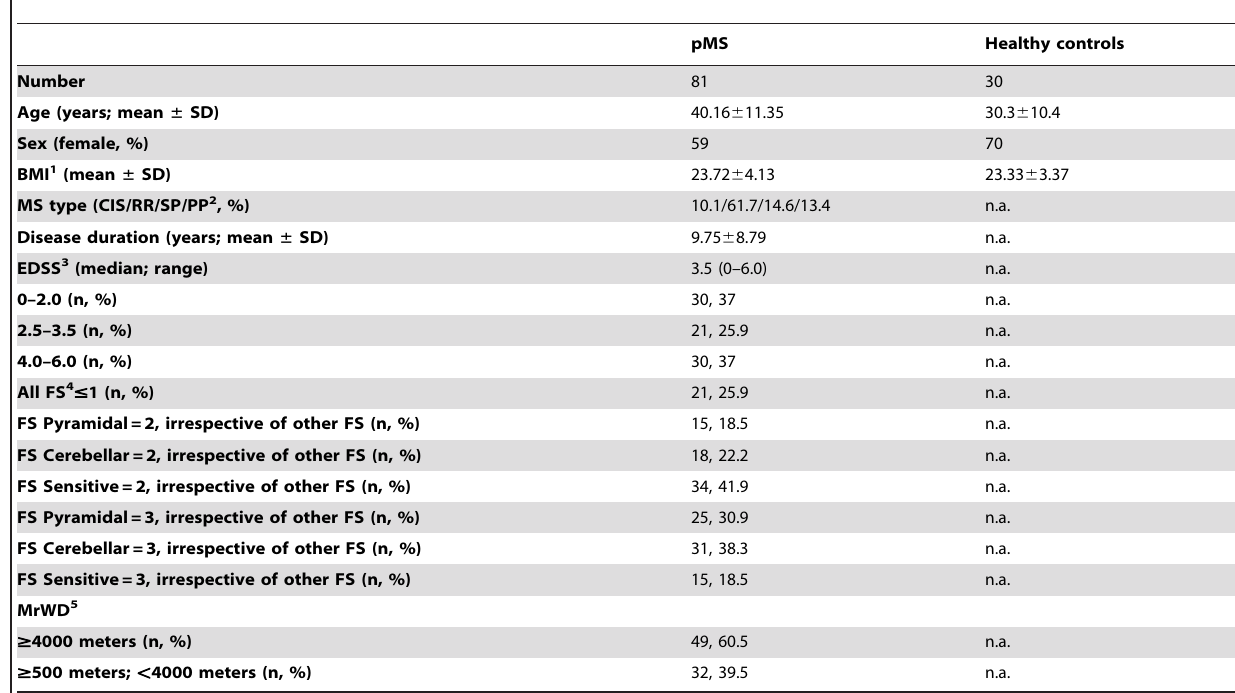
Table 1. Baseline characteristics of people with MS and healthy control